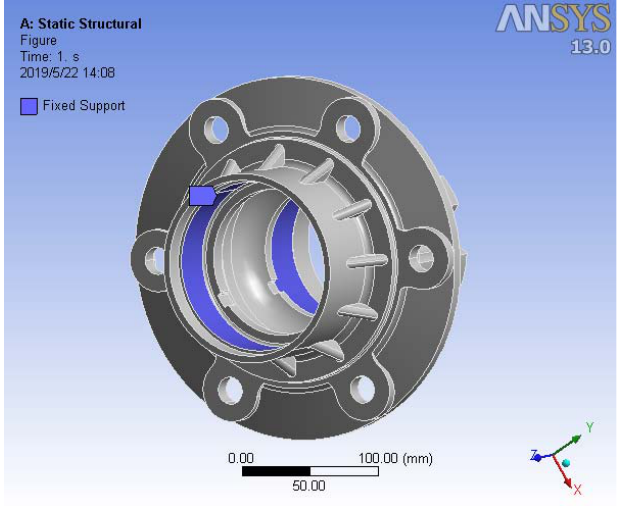
Figure 6. Positions of the constraints applied to the wheel hub.